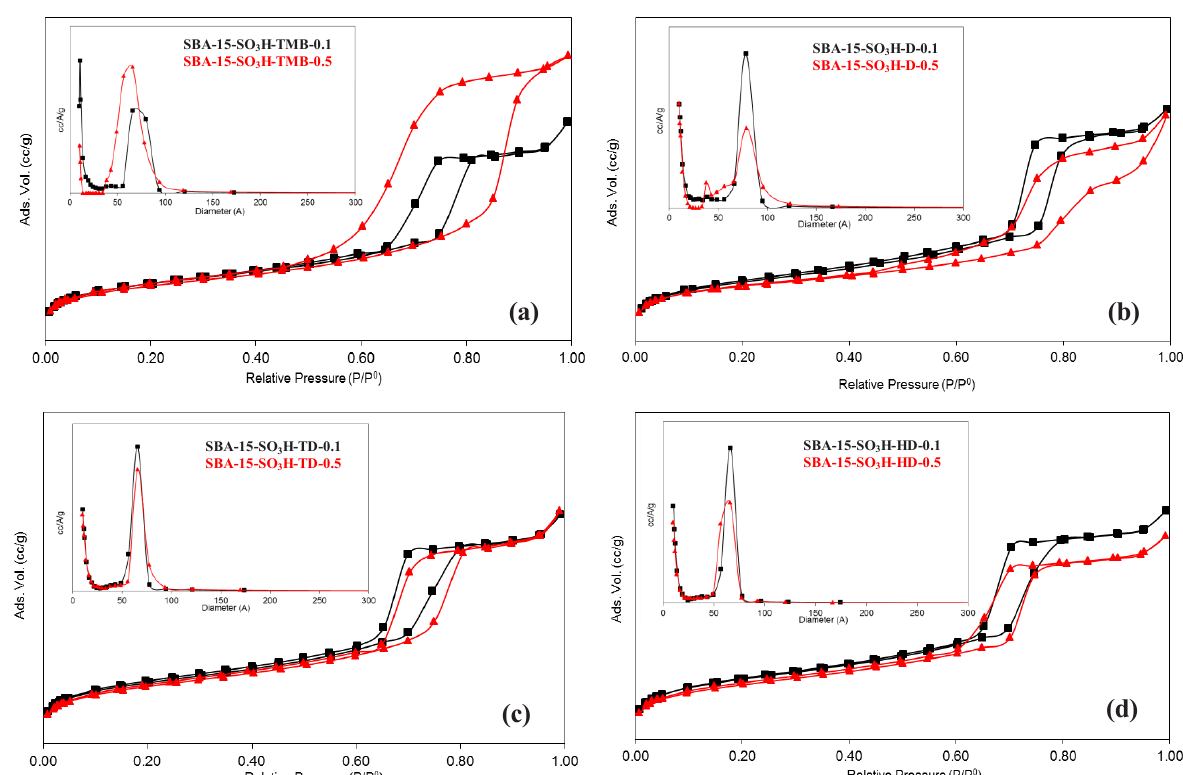
Figure 4: (a) N 2 -sorption isotherms and pore size distributions (inset) of SBA-15-SO 3 H-TMB. (b) N 2 -sorption isotherms and pore size distributions (inset) of SBA-15-SO 3 H-D. (c) N 2 -sorption isotherms and pore size distributions (inset) of SBA-15-SO 3 H-TD. (d) N 2 -sorption isotherms and pore size distributions (inset) of SBA-15-SO 3 H-HD. Table 2: The structural (from BET/BJH analysis) and acidic properties of the samples. Samples S BET (m 2 /g) V pore (cm 3 /g) Acid Capacity (mmol H + /g)